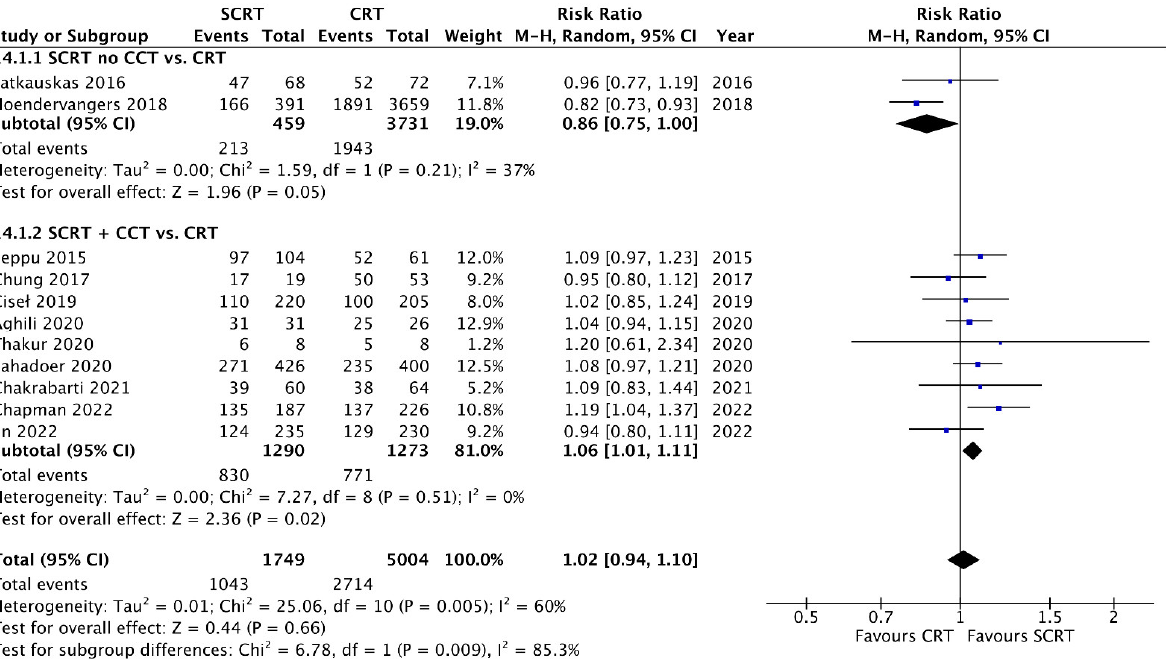
Figure 8. Forest plot of the sphincter-preservation rate.